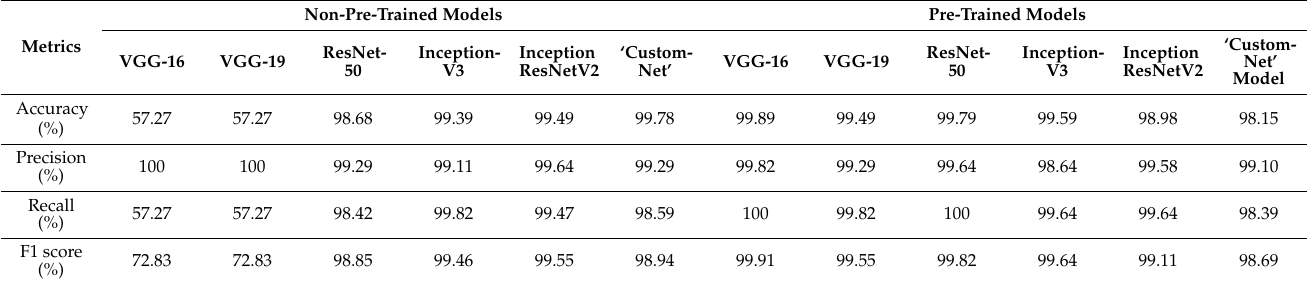
Table 6. Classification performance of different deep learning models.